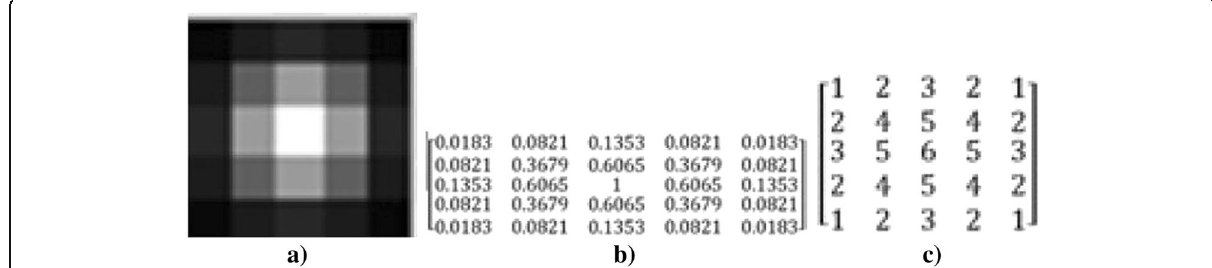
Fig. 3 A weighting window used in the WM filter. a 5 × 5 Gaussian surface. b Intensity values of a Gaussian surface. c Weighting window after